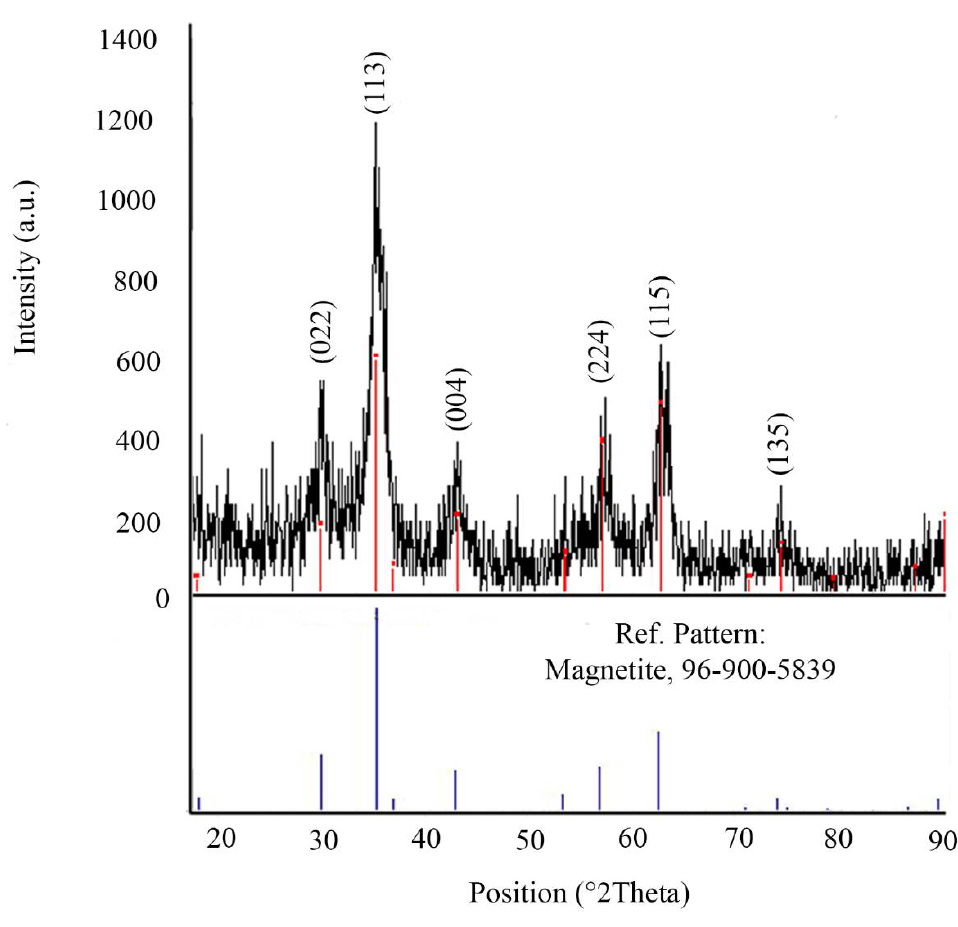
Figure 1. X-ray spectra of Lys@Fe 3 O 4 nanoparticles.